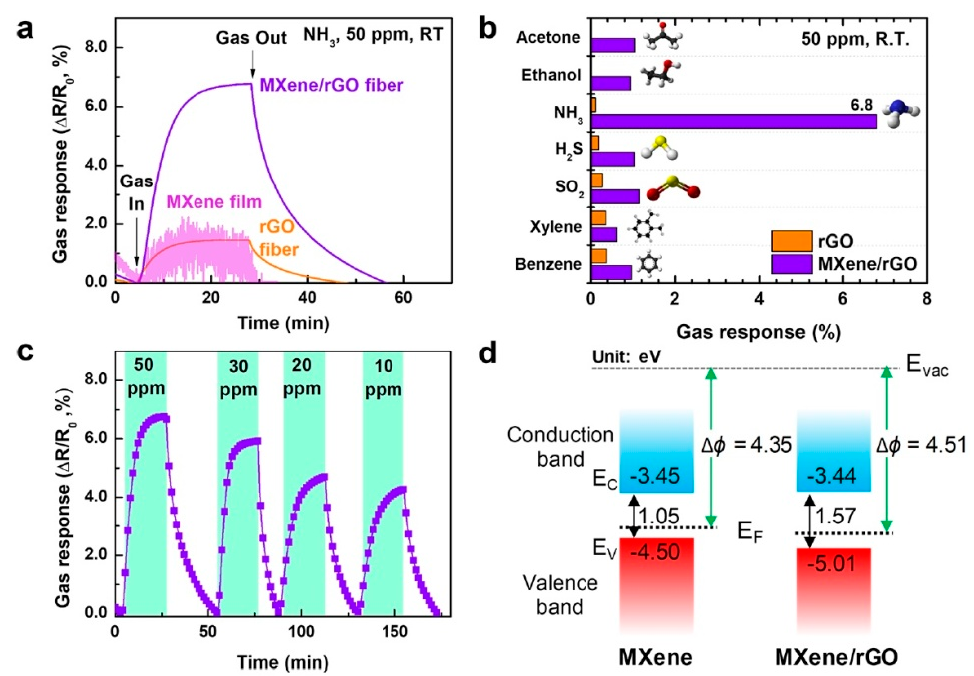
Figure 36. ( a ) Comparison of the gas response of MXene film, rGO fiber, and MXene/rGO hybrid fiber (40 wt.% MXene); ( b ) gas selectivity comparison of rGO fiber and MXene/rGO hybrid fiber (40 wt.% MXene) to various testing gases at concentrations of 50 ppm; ( c ) dynamic resistance response of the sensor based on MXene/rGO hybrid fiber (40 wt.% MXene) to different NH 3 concentrations in the range of 10–50 ppm at room temperature; and ( d ) schematic energy-level diagram of MXene, and MXene/rGO (40 wt.% MXene). Reprinted with permission from [166]. Copyright 2020: Ameri- can Chemical Society.